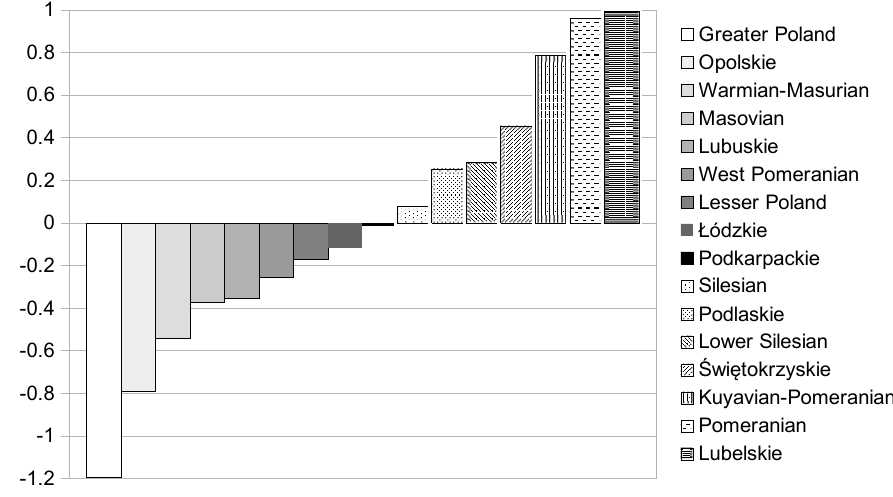
Figure 1. Comparison of Polish voivodeships with respect to the increasing value of the W A indicator. Source: Authors’ calculations.